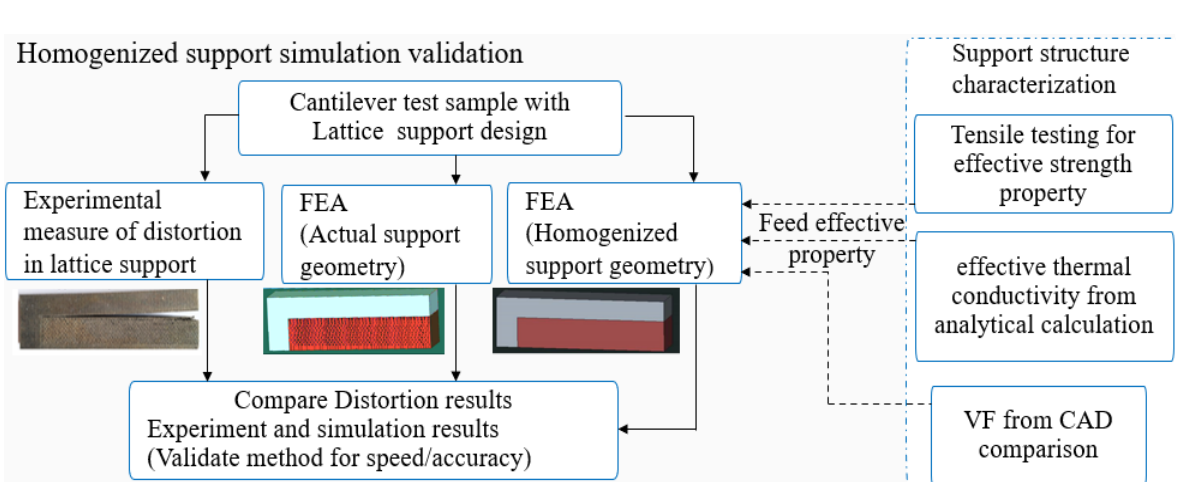
Figure 2. Flow chart for a homogenized support simulation approach.